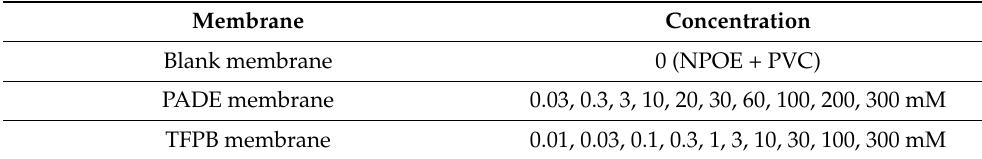
Table 1. Concentrations of TFPB and PADE in membranes.